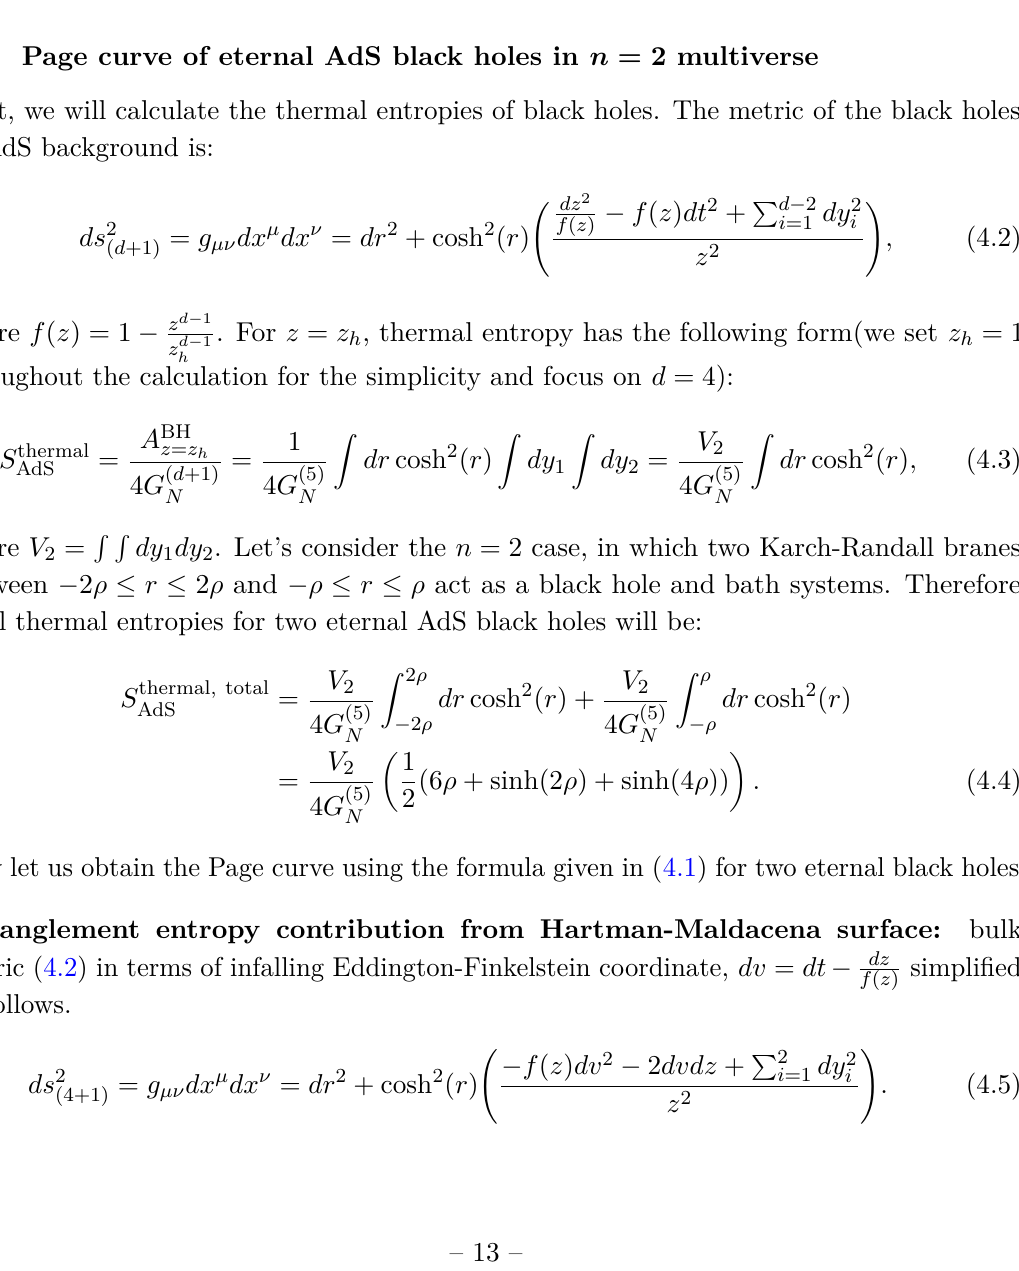
Figure 6 . In this figure, we assume that n black holes contained in Q 1 , 2 ,...,n emit Hawking radiation which is collected by baths Q . Green and yellow curves represent island surfaces between − 1 , − 2 ,..., − n Q − n and Q n , Q − 1 and Q 1 respectively. The red curve represents the Hartman-Maldacena surface starting at the defect and meets its thermofield double partner. δM is the AdS